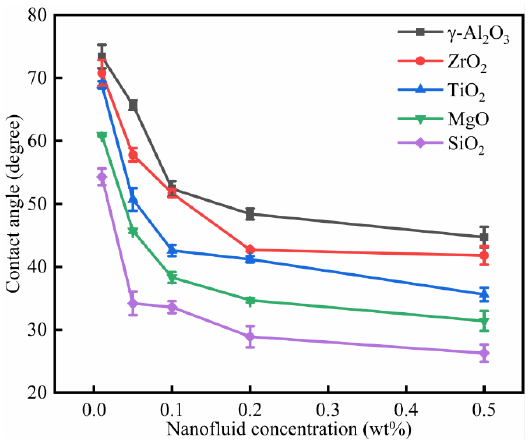
Figure 15. The nanofluid concentration effect on oil-wet calcite wettability (25